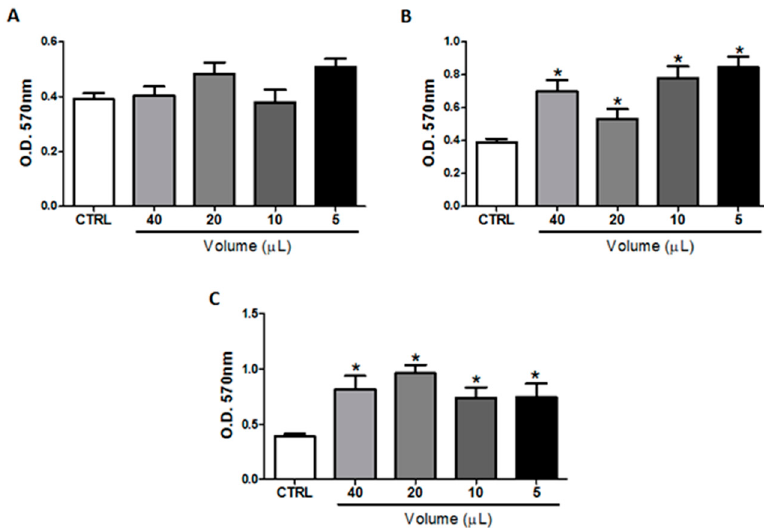
Figure 1. Cell viability assay. B16F10 cells were cultured with different concentrations (40, 20, 10, and 5 μL) of fish oil rich in omega-3 ( A ) or soybean oil rich in omega-6 ( B ) or a mixture of these oils in a ratio of 1:1 ( C ) for 48 h. The risk value α was set at 5% ( p < 0.05). * p < 0.05.